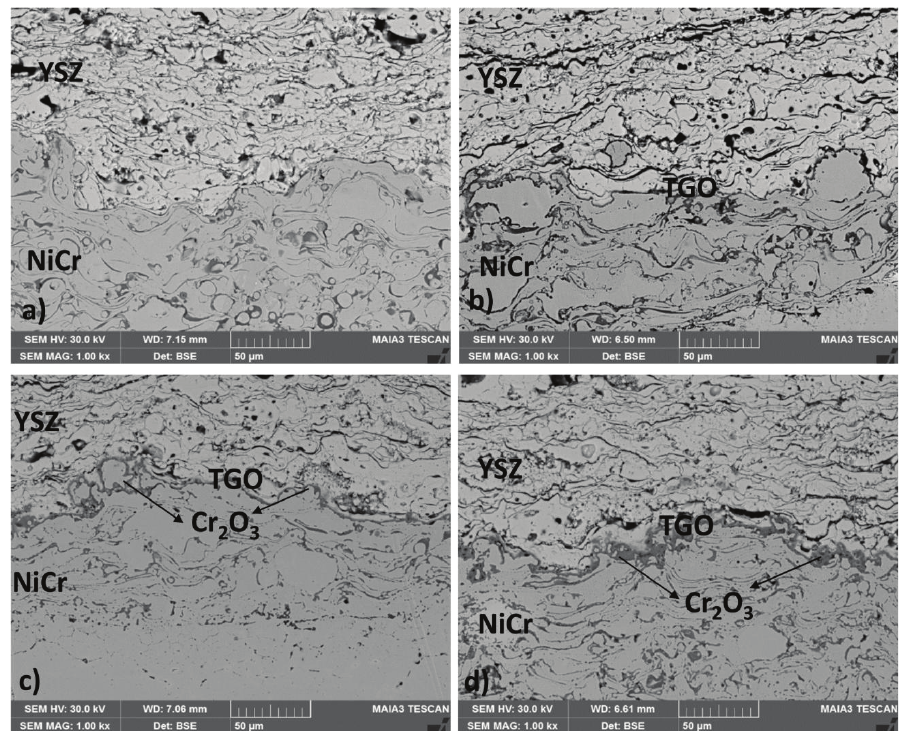
Figure 3: SEM microstructures after a) as-sprayed, b) 8 h, c) 24 h and d) 50 h oxidation tests at 1000°C .